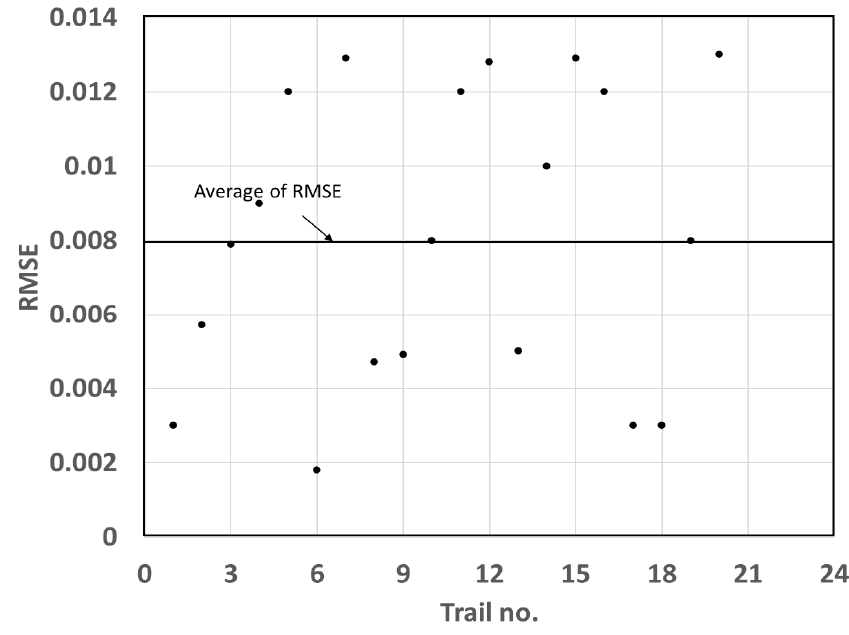
Figure 10. Values of the root mean square error (RMSE) derived from repeated holdout cross-vali- dation.